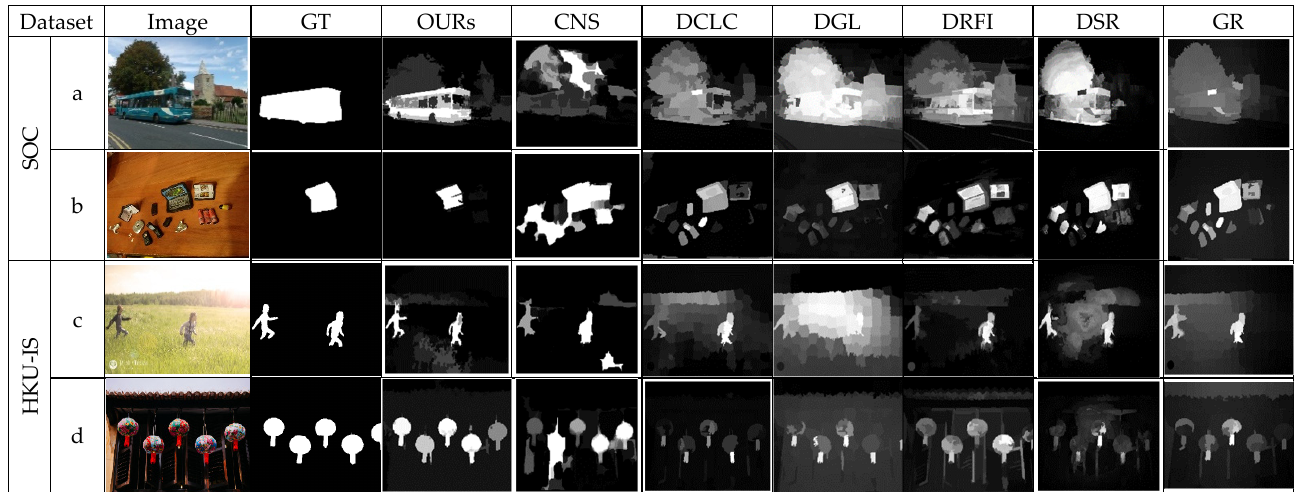
Figure 4. Qualitative performance of the proposed method, CNS, DCLC, DGL, DRFI, DSR and, GR on SOC and HKU-IS datasets: ( a ) Salient object with the heterogeneous background; ( b ) Salient object surrounded by multiple non-salient objects; ( c ) Salient objects with illumination change; ( d ) Multiple salient objects.